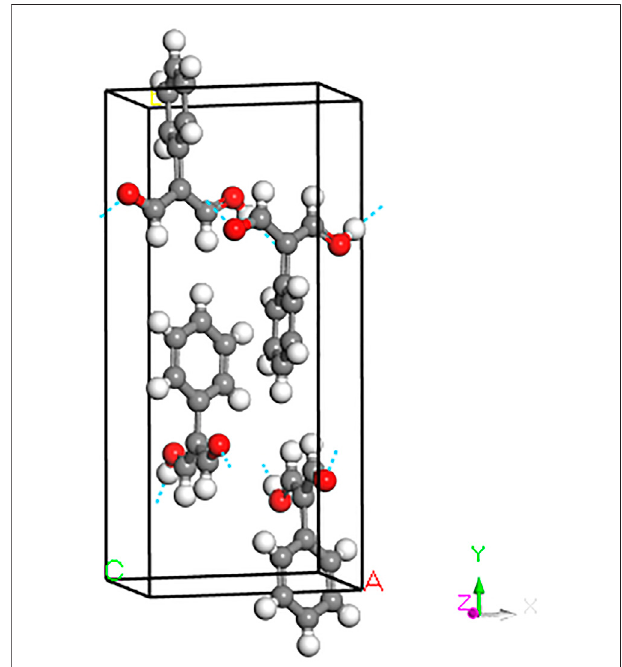
FIGURE 1 | Unit cell of PhMDA as obtained after full geometry optimisation on the experimental structure [4]. See text for more details. Gray: C, white: H, red: